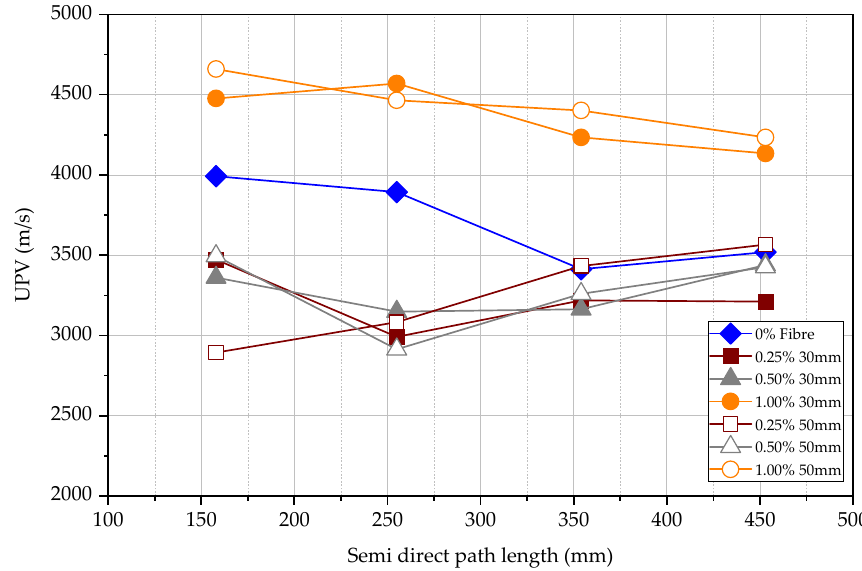
Figure 15. Semi-direct UPV measurement vs. path length at 3 days.